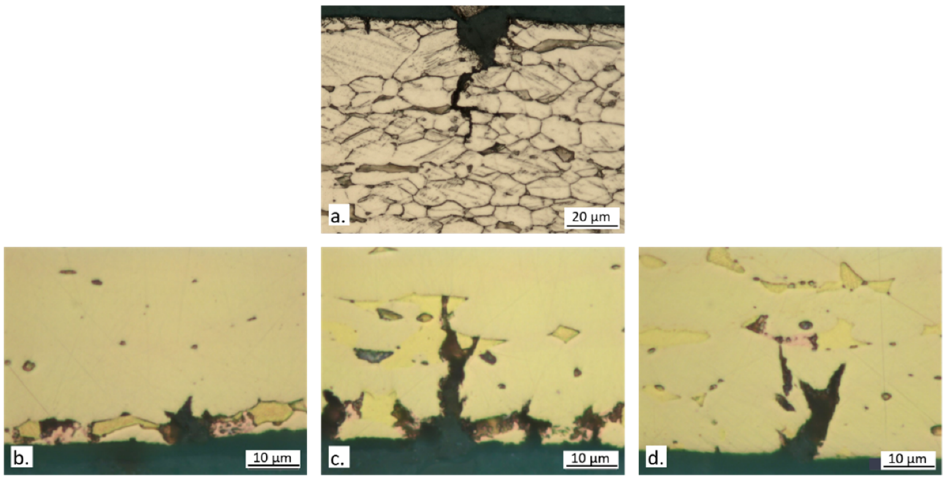
Figure 16. Fractographic analysis of CW602N tensile samples after SSRT carried out in ( a ) air or in SDW solutions containing ( b ) 100 ppm; ( c ) 400 ppm; and ( d ) 700 ppm chlorides.